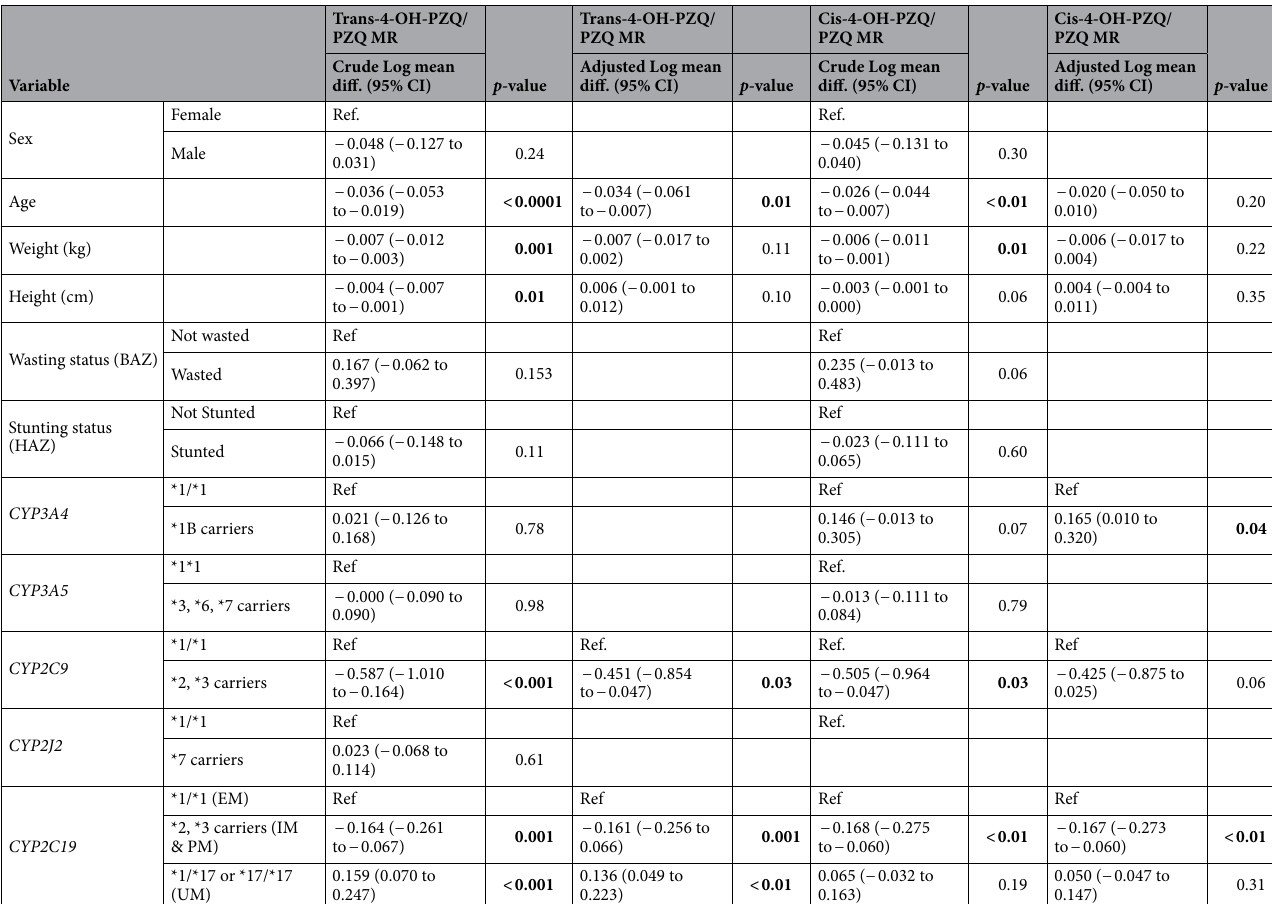
Table 4. Factors associated with Praziquantel metabolic ratios ( trans-4-OH-PZQ/PZQ and cis-4-OH-PZQ/ PZQ ). BAZ body mass index (BMI) for age Z score, EM extensive metabolizers, HAZ height for age Z